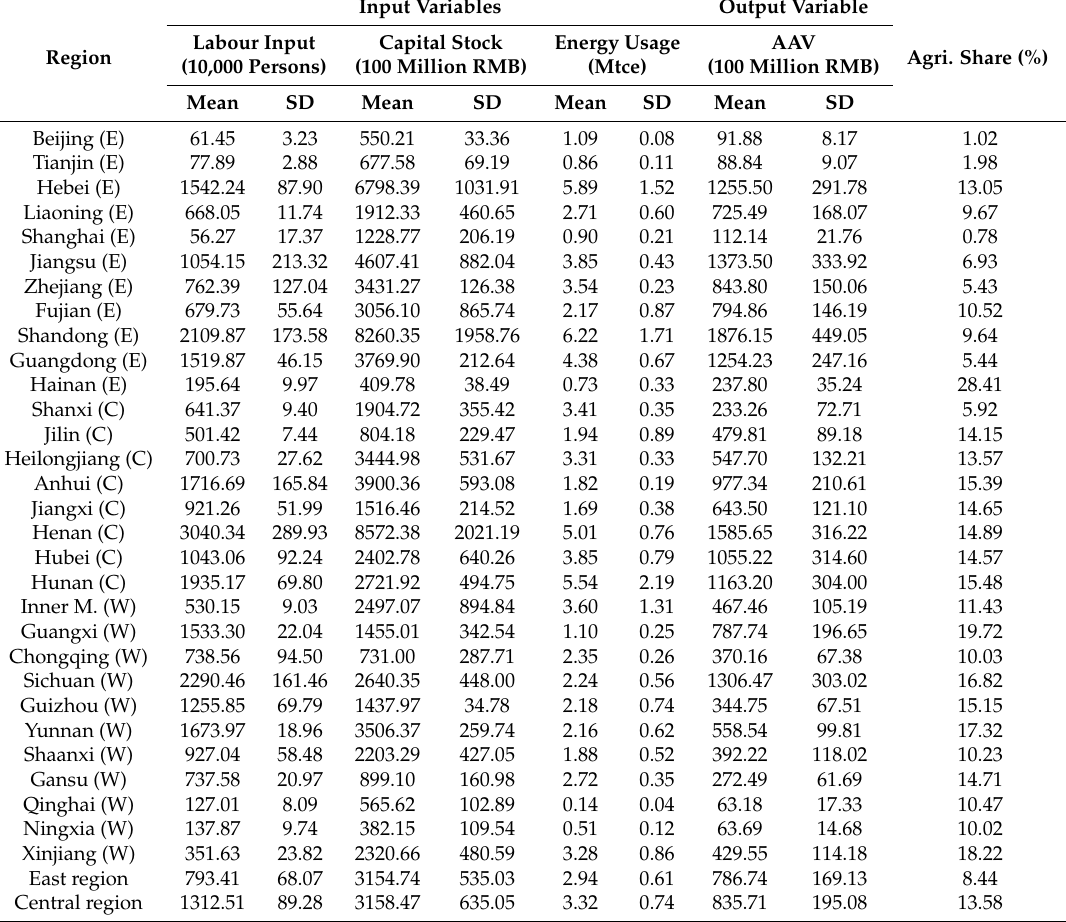
Table 1. Summary statistics of input and output variables by